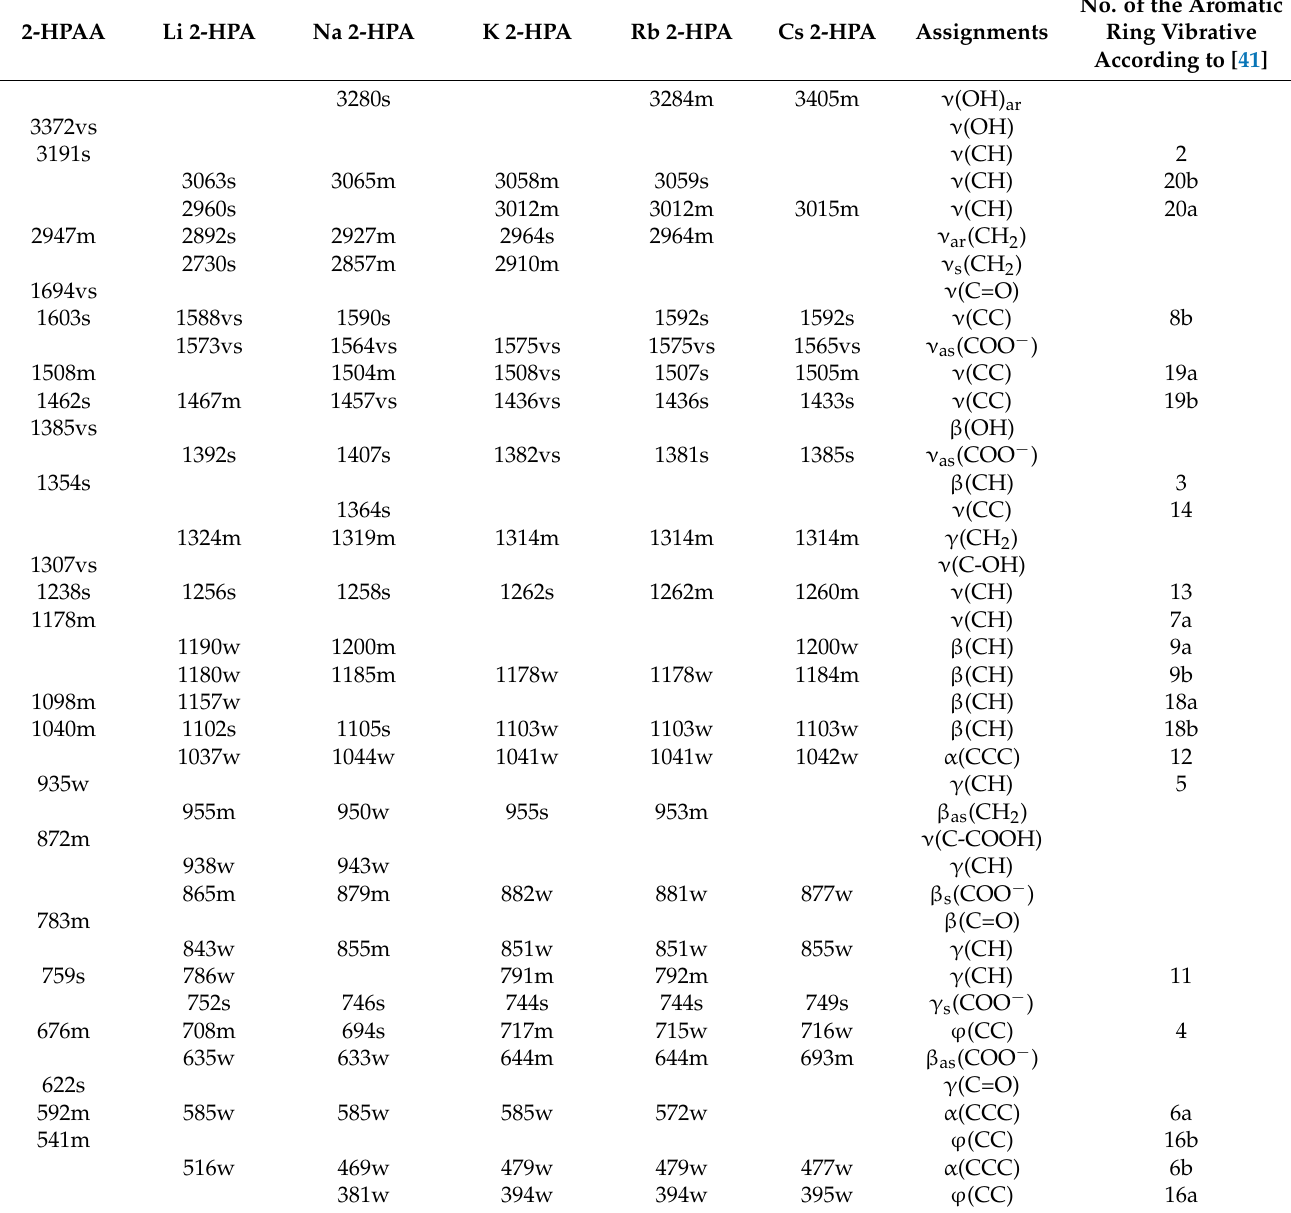
The wavenumbers, intensities, and assignments of the chosen bands from the FT-IR spectra of 2-hydroxyphenylacetic acid and lithium, sodium, potassium, cesium, and rubidium